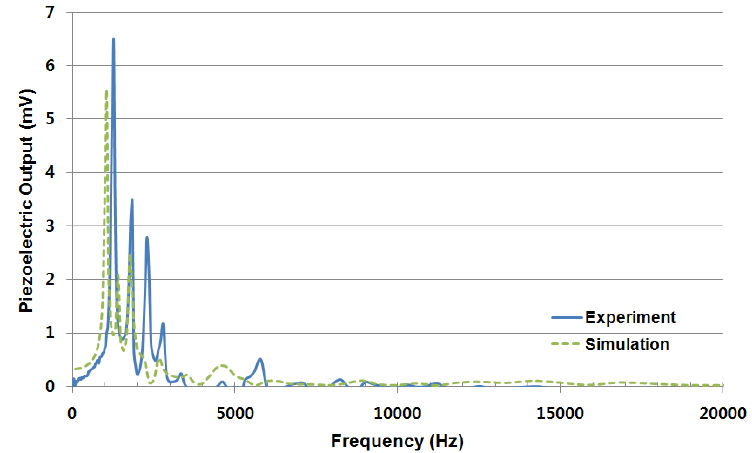
Figure 10. Piezoelectric signal output of line electrode #3.